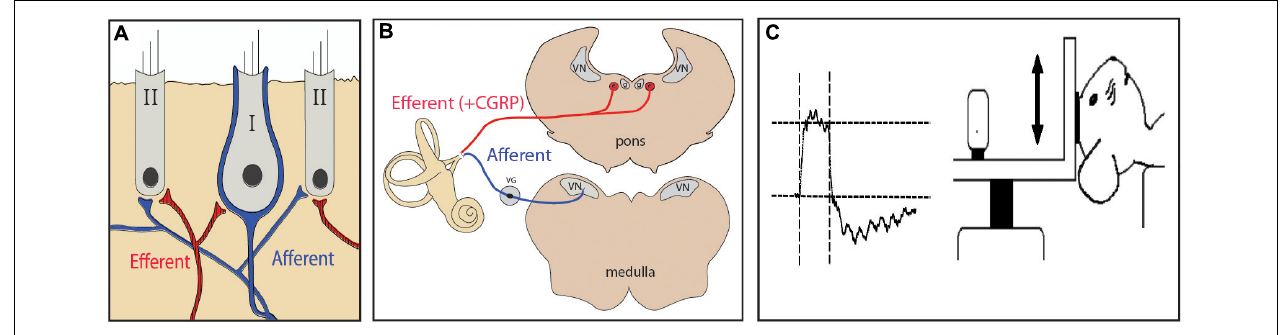
FIGURE 1 | (A) Efferent neurons synapse directly onto calyceal afferents innervating vestibular type I hair cells. (B) Vestibular afferents project into the brainstem and synapse in the vestibular nuclei. Efferent cell bodies are found in the brainstem medial to the vestibular nuclei. (C) For otolith testing using vestibular evoked potentials (VsEP), a linear jerk pulse is applied to the mouse’s head via a mechanical shaker that moves the head along the naso-occipital axis.